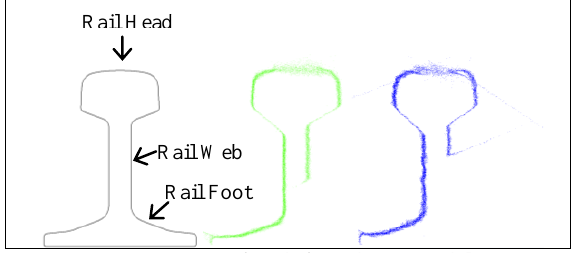
Figure 3 - Cross-section of track from design model, Scanner A (centre) and Scanner B